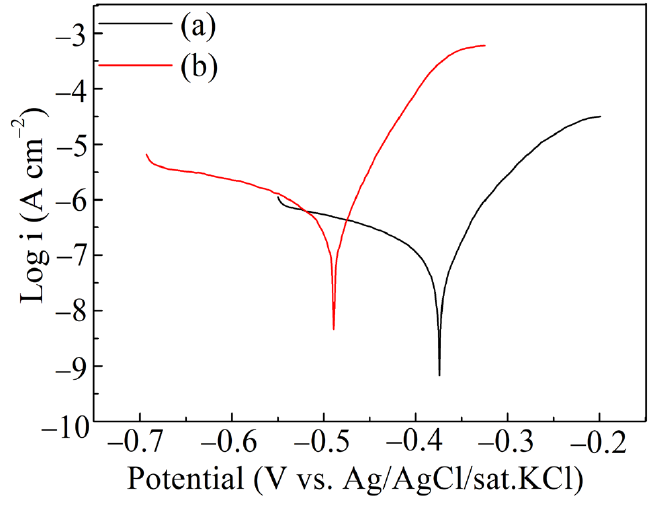
Figure 7. Potentiodynamic polarization curves of (a) stearic-acid-treated sample after Na 2 CO 3 etching after abrasion test and (b) stearic-acid-treated sample after NaOH etching at 90 °C after abrasion test. Table 4. Corrosion current density ( i corr ), polarization resistance ( R p ) and corrosion potential ( E corr ) of (a) stearic-acid-treated sample after Na 2 CO 3 etching after abrasion test and (b) stearic-acid-treated sample after NaOH etching at 90 ◦ C after abrasion